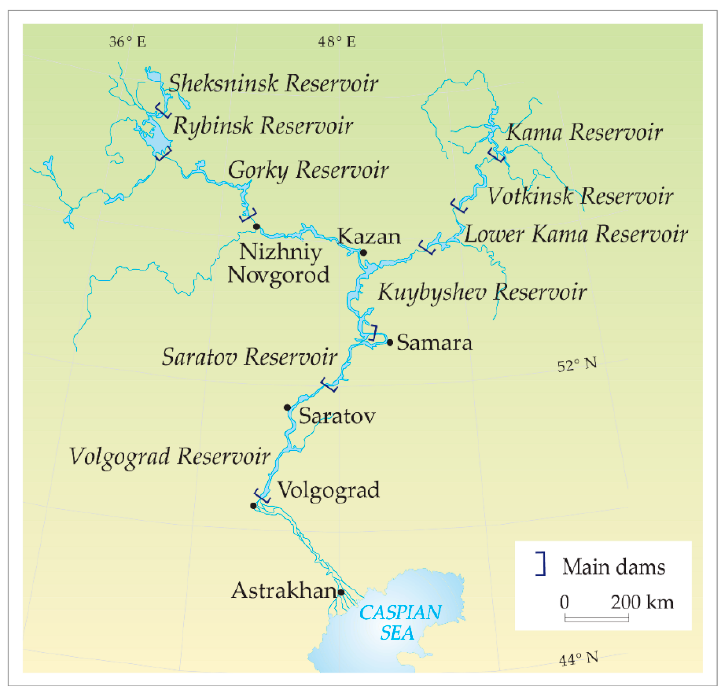
Figure 7. Water reservoirs along the Volga Delta river.